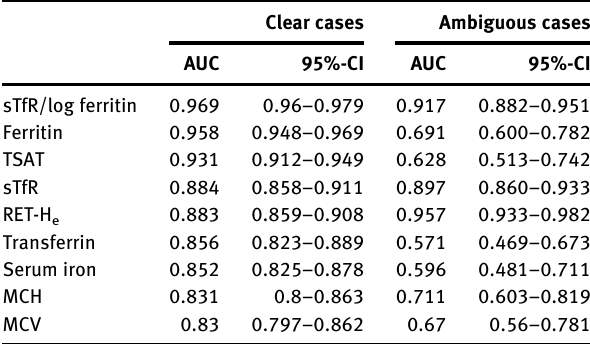
differentiate between IDA and ACD, divided into clear (manual classi fi cation and TP identical) and ambiguous